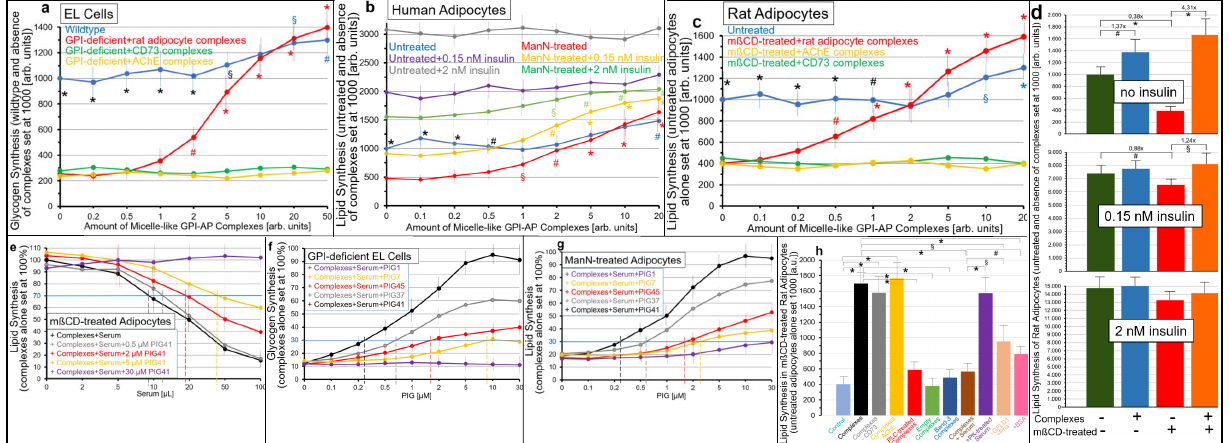
Figure 7. Stimulation of glycogen and lipid synthesis by micelle-like GPI-AP complexes in acceptor cells and effect of serum proteins and PIGs. ( a – d ) Wildtype and GPI-deficient EL cells ( a ), untreated and ManN-treated human adipocytes of lipid-loading stage II ( b ) or untreated and mßCD-treated rat adipocytes ( c , d ) were incubated (30 min, 37 ◦ C) without or with micelle-like GPI-AP complexes ( a – c , increasing amounts; d , 10 arb. units), reconstituted with total rat adipocyte GPI-APs ( a – d ), bAChE or rCD73 ( a , c ) as described in Materials and Methods, in the absence ( a , c ) or presence ( b , d ) of half-maximal (0.15 nM) and maximal (2 nM) effective concentrations of insulin and then assayed for glycogen ( a ) or lipid ( b – d ) synthesis as described in Materials and Methods. ( a – d ) The mean values ± SD (4–6 independent incubations and assays, each) of the synthesized glycogen and lipid are given as arb. units set at 1000 for incubation of wildtype or untreated cells without complexes as well as insulin. Significant increases vs. absence of complexes are indicated by colored symbols. Significant differences between wildtype and GPI-deficient EL cells or untreated and treated adipocytes are indicated by black symbols. ( d ) Lipid synthesis in mßCD-treated rat adipocytes is given for untreated adipocytes in the absence of complexes set at 1000 arb. units. ( e – g ) mßCD-treated rat adipocytes ( e ), GPI-deficient EL cells ( f ) and ManN-treated human adipocytes ( g ) were incubated (30 min, 37 ◦ C) with micelle-like GPI-AP complexes from total rat adipocyte GPI-APs (20 arb. units) in the absence or presence of serum ( e , increasing volumes; f , g , 50 µ L) as well as increasing concentrations of PIGs and then assayed for lipid ( e , g ) or glycogen ( f ) synthesis. ( e – g ) The mean values ± SD (3–7 independent incubations and assays, each) of the synthesized glycogen and lipid are given with complexes alone set at 100%. The volumes of serum ( e ) or concentrations of PIGs ( f , g ) required for 30% decrease (horizontal blue line) in lipid synthesis ( e ; IV 30 ) or 30% increase (horizontal blue lines) in glycogen ( f ; EC 30 ) or lipid ( g ; EC 30 ) synthesis are given by the hatched vertical lines for each PIG. ( h ) mßCD- treated rat adipocytes were incubated (30 min, 37 ◦ C) in the absence (light blue bar) or presence of micelle-like GPI-AP complexes from total rat adipocyte GPI-APs (20 arb. units), which had been left untreated (black bar) or immune depleted from rCD73 (grey bar) or rAChE (yellow bar) or treated with bacterial PI-PLC (red bar) or with complexes that had been reconstituted without proteins (green bars) or with erythrocyte Band-3 (dark blue bar) or with complexes together with untreated serum (50 µ L, brown bar) or PK-treated serum (pink bar) or GPLD1 (0.2 units/mL) together with Pha (2 mM, orange) or BSA (50 mg/mL, light red) and then assayed for lipid synthesis. The mean values ± SD (four or five independent incubations and assays, each) of the synthesized lipid are given as arb. units set at 1000 for incubation of untreated rat adipocytes without complexes. Significant differences are indicated (* p ≤ 0.01, # p ≤ 0.02 and § p ≤